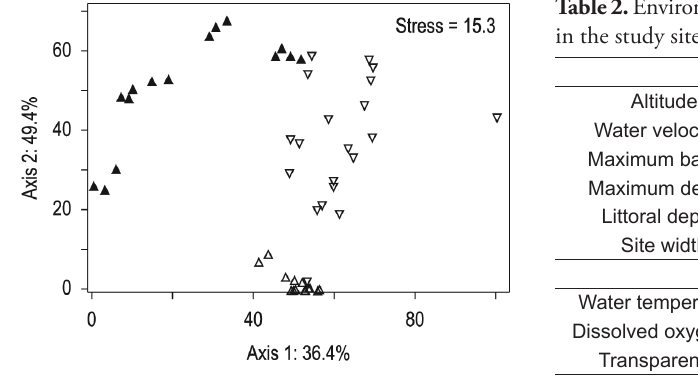
Figure 2. NMDS results for individual fish diet compo- sition across species (  = O. niloticus ,  = G. brasiliensis ,  = P. managuensis ), with variance explained for each axis and stress value.